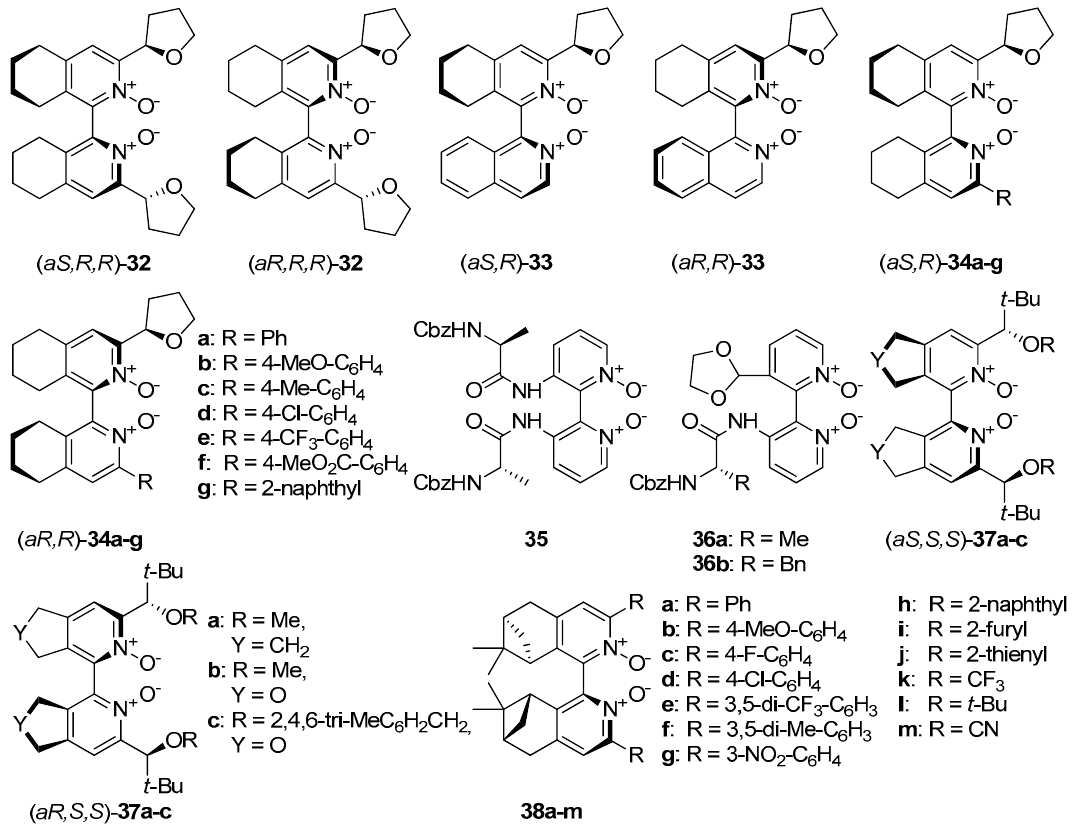
Figure 7. N -Oxides possessing two types of chirality—central and axial.